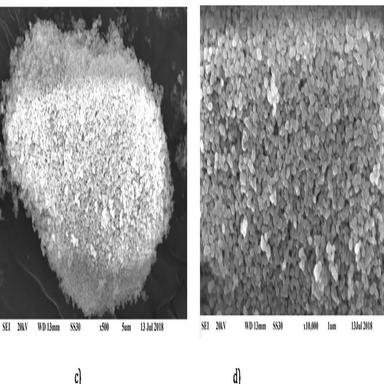
SEM images of a) PVP at ×500 scale b) PVPO at ×500 scale c) Hybrid Material at ×500 scale and d) Hybrid Material at ×10 k scale.